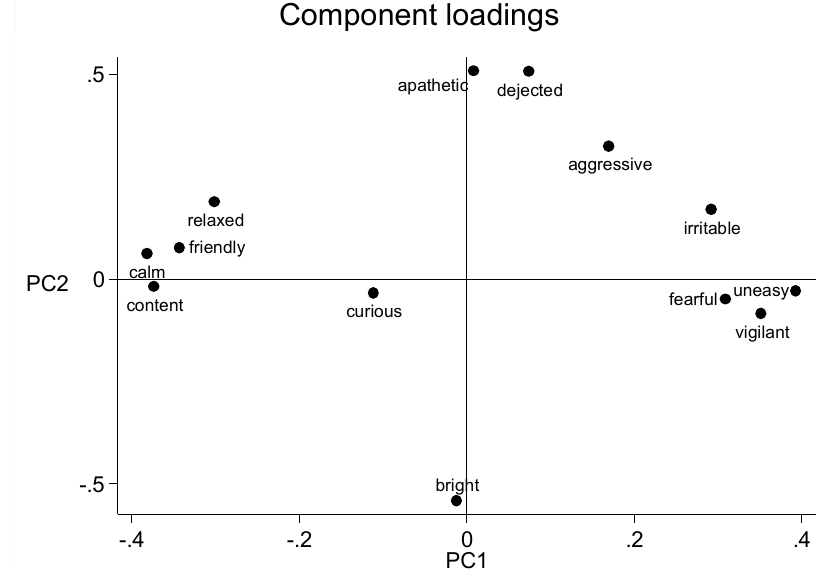
Figure 2. Loading plots generated by the second scoring session for all observers. The x-axis represents principal component 1 and the y-axis represents principal component 2.